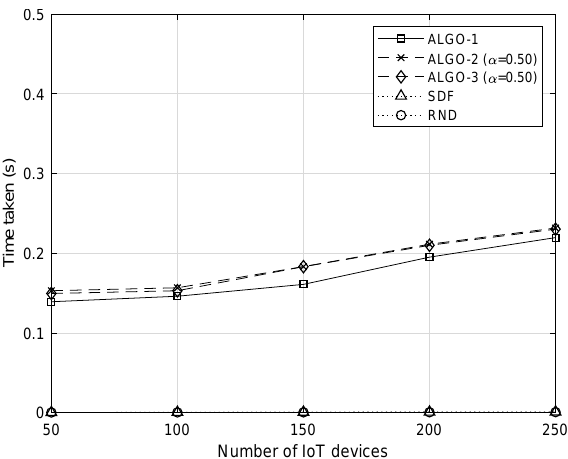
Figure 10. Average time taken to solve the given optimization problem when v =